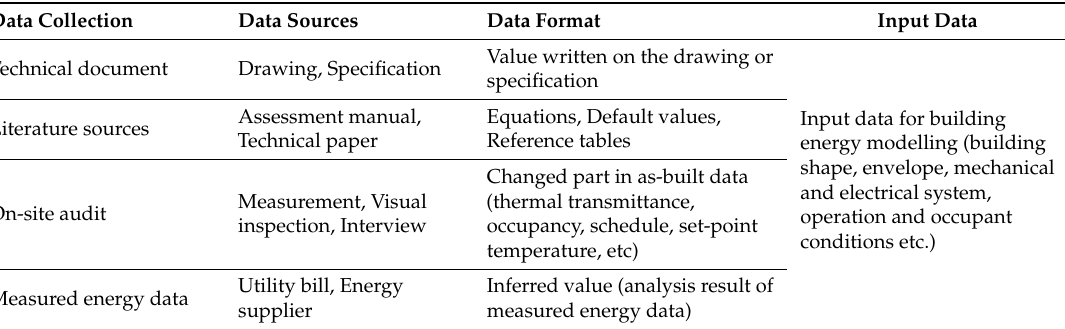
Table 2. Data collection methods.